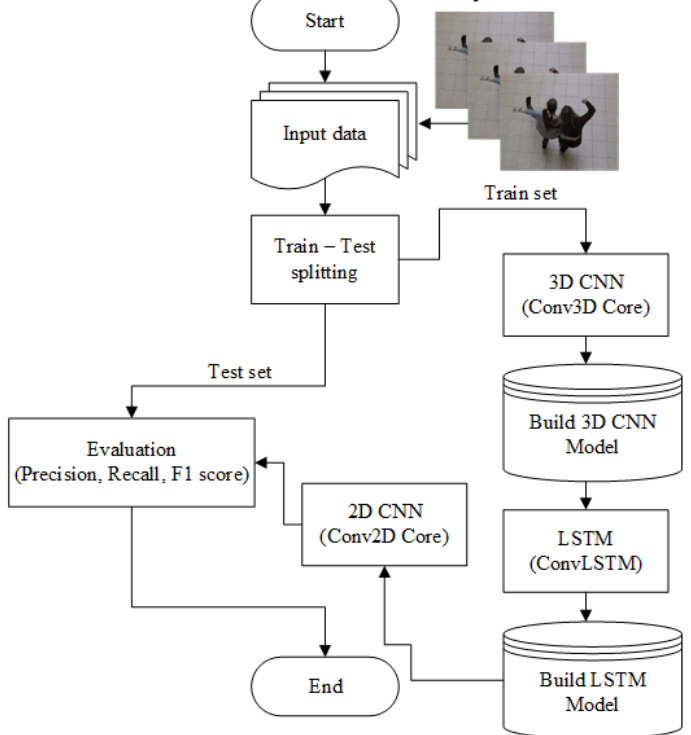
Figure 4. The flowchart of the proposed